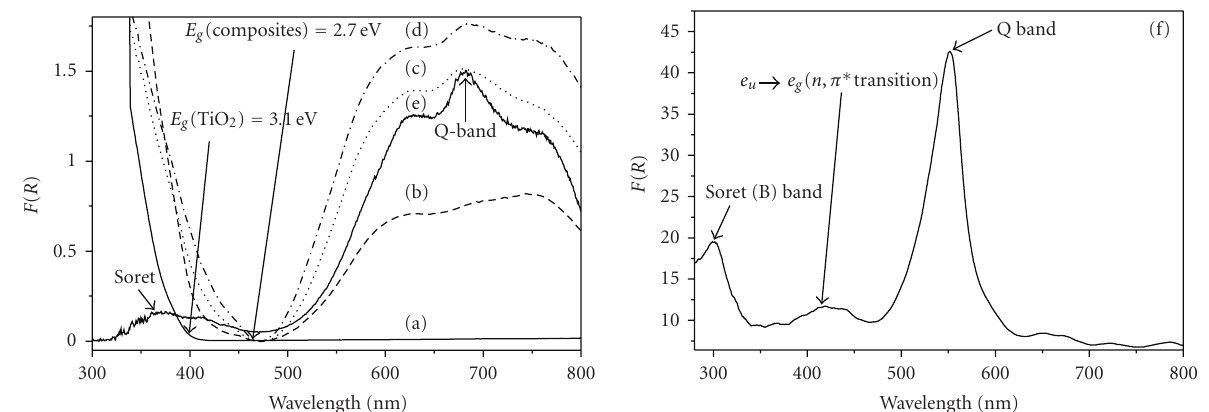
Figure 2: Di ff use reflectance spectra of TiO 2 /ZnPc composites, prepared with di ff erent percent in mass of ZnPc: (a) TiO 2 P25. Composite containing: 1.0% of ZnPc (b); 2.5% of ZnPc (c); 5.0% of ZnPc (d); (e) composite containing 2.5% of ZnPc (TiO 2 P25 was used as reference), showing the Soret (370nm) and Q (683 nm) bands, typical of ZnPc; (f) di ff use reflectance spectrum of pure ZnPc. Barium sulphate was used as reference for (a) to